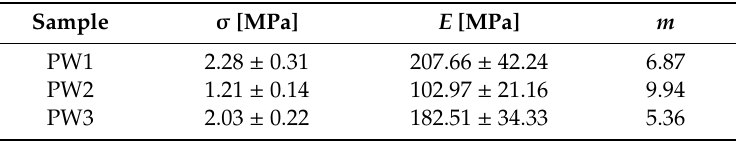
Table 4. Bending properties of the tested multilayer beams with SiC.